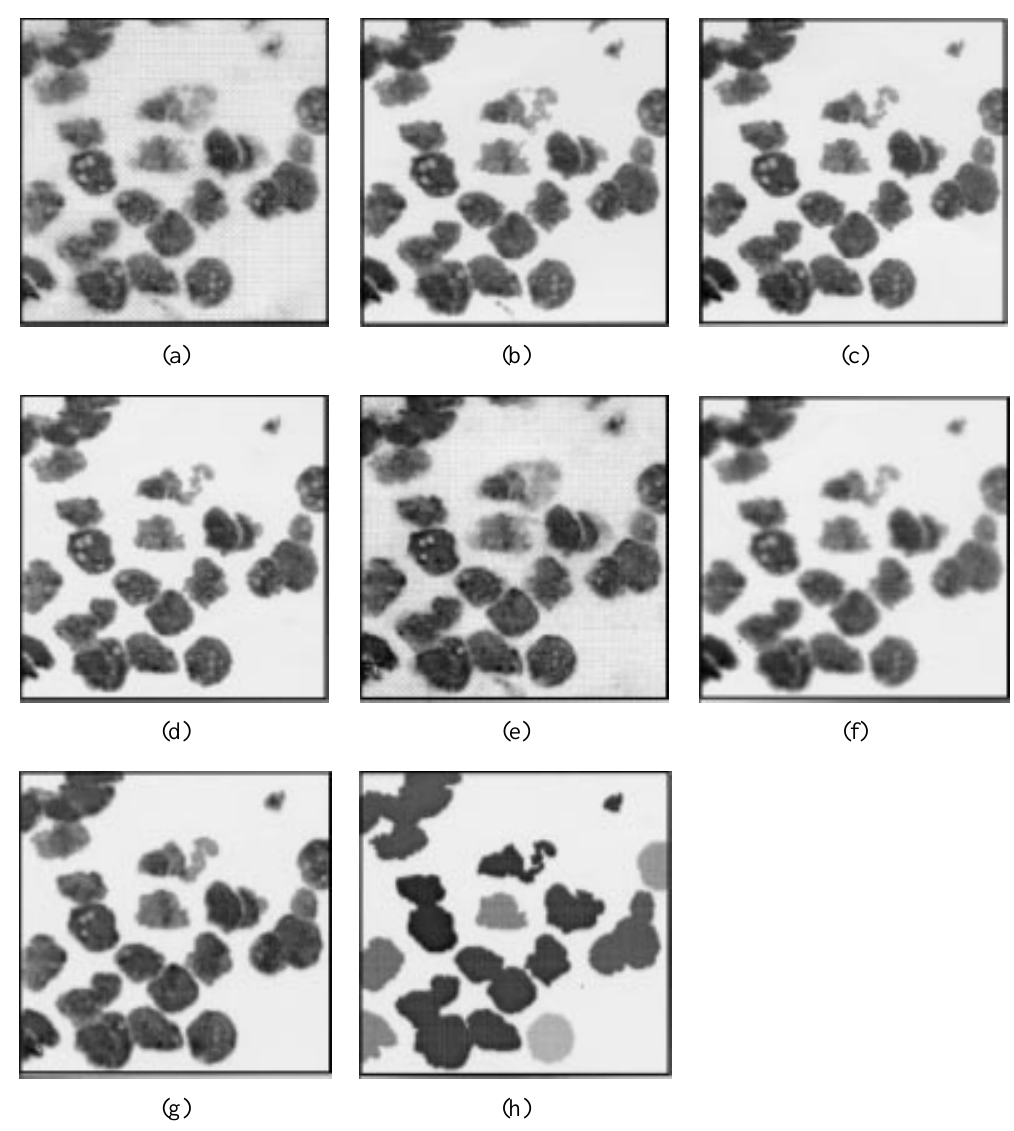
Fig. 1. (a) Original image; (b) after window slicing; (c) after size and shape filtering; (d) after opening; (e) after edge enhancement; (f) after spatial averaging; (g) after directional Gaussian smoothing; (i) after volumetric region growing and